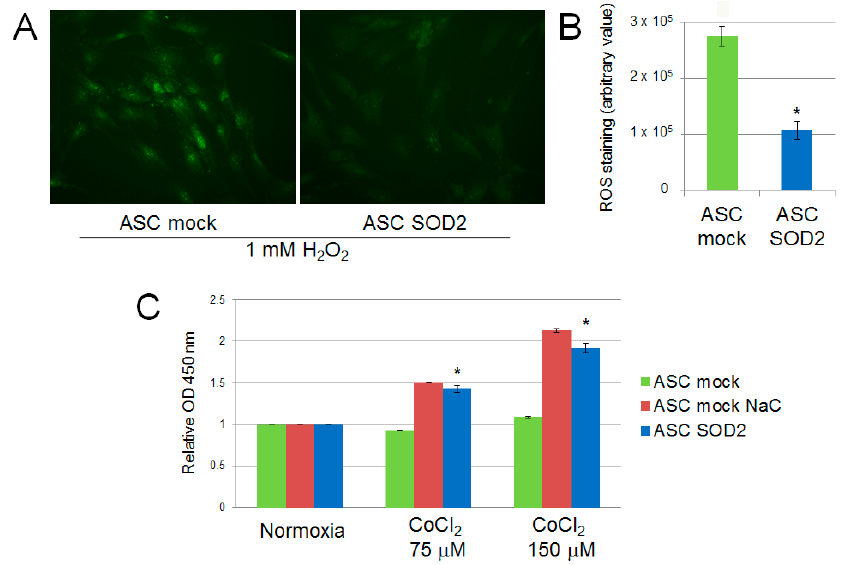
Figure 2. ROS production in SOD2 overexpressing human ASC after acute hypoxic challenge (1 mM H 2 O 2 for 30 min) assessed using ( A ) the CellROX oxidative stress fluorogenic probe (original magnification 40×) and ( B ) fluorescence quantification with ImageJ software. Cell viability assay after 24 h of culture in cobalt chloride-induced hypoxic conditions ( C ). Treatment with the antioxidant scavenger N-acetylcysteine (NaC) (2 mM) was used as control. Results are reported as mean ± S.E.M. of three independent experiments. Significance was assessed by Mann–Whitney U test; * p < 0.05 versus ASC mock.